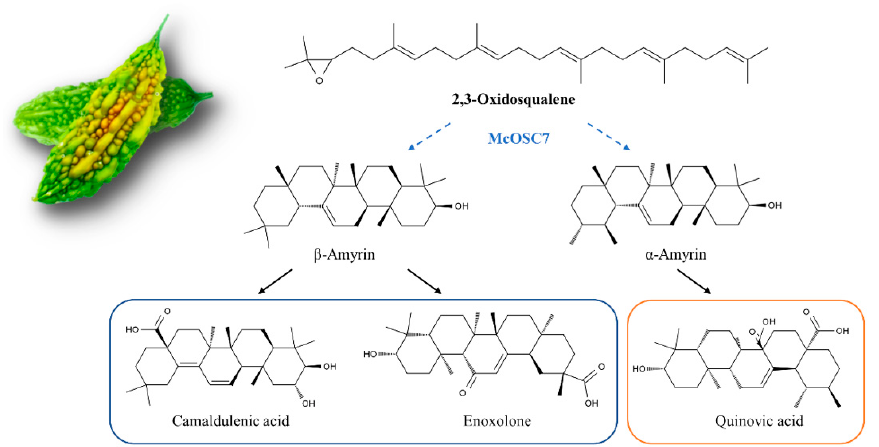
Figure 5. Effect of bitter gourd McOSC7 on triterpene synthesis. Overexpression of McOSC7 in hairy roots increased the contents of camaldulenic acid, enoxolone, and quinovic acid. Dotted arrows represent possible intermediates; solid arrows represent detected final products.